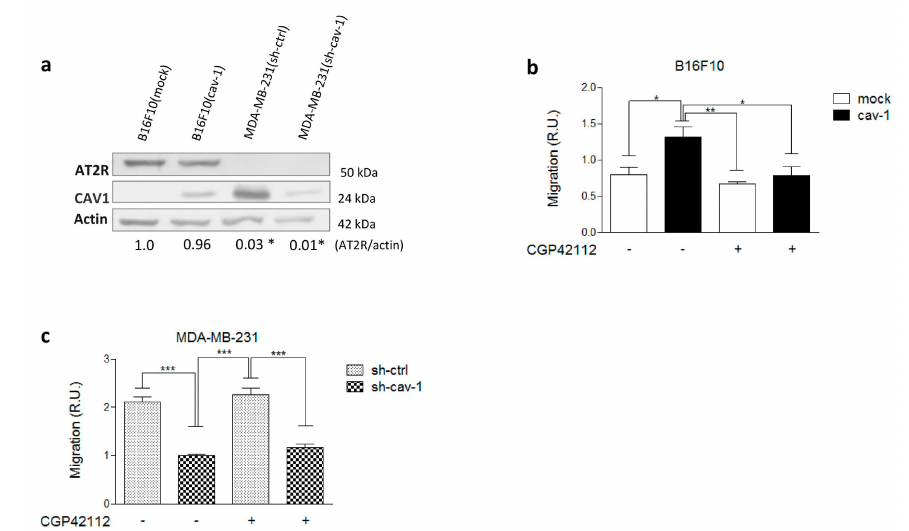
Figure 1. B16F10 cells express angiotensin II type-2 receptor (AT2R), and its activation decreases migration while AT2R is undetectable in MDA-MB-231. ( a ) Immunoblots of B16F10 melanoma and MDA-MB-231 cell lysates with antibodies against AT2R, caveolin-1 (CAV1), and β -actin. The numbers below individual lanes show the averaged AT2R / actin ratios normalized to B16F10(mock) (N = 3). B16F10(mock) (1.0 ± 0.04), B16F10(cav-1) (0.96 ± 0.22), MDA-MB-231(sh-ctrl) (0.03 ± 0.01), and MDA-MB-231(sh-cav-1) (0.01 ± 0.01). Migration assay with B16F10 ( b ) and MDA-MB-231 ( c ) cells were performed as described. Both cell lines were pretreated for 30 min with the AT2R agonist N- α − Nicotinoyl-Tyr-Lys-(N- α -Z-Arg)-His-Pro-Ile (CGP42112). The graphs show values normalized to the average of the control condition (N = 3) (mean ± standard error of mean). Results obtained were compared statistically as explained in Materials and Methods. Significant di ff erences are indicated as *** p ≤ 0.001, ** p ≤ 0.01, and * p ≤ 0.05. (R.U., relative